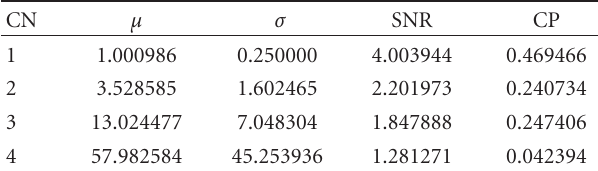
Table 1: Statistical information about the best class number for experimental phantom data set.